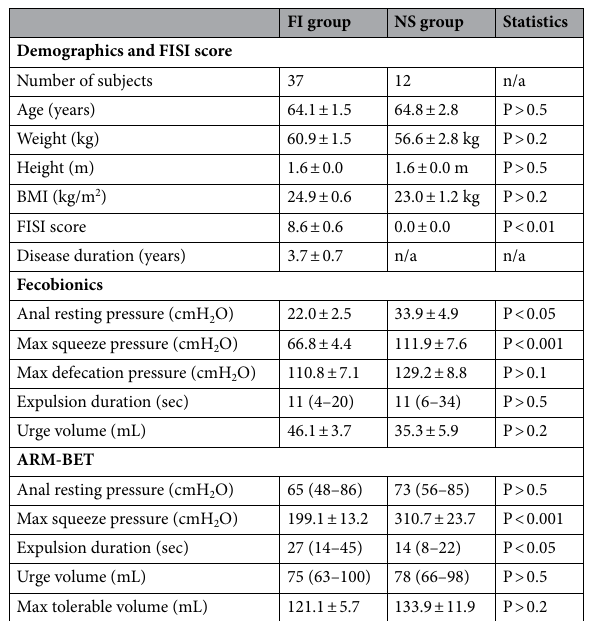
Table 1. Demographics, fecal incontinence severity index (FISI) score, Fecobionics, anorectal manometry (ARM) and balloon expulsion test (BET) data for fecal incontinence (FI) patients and normal subjects (NS). Data in parentheses are